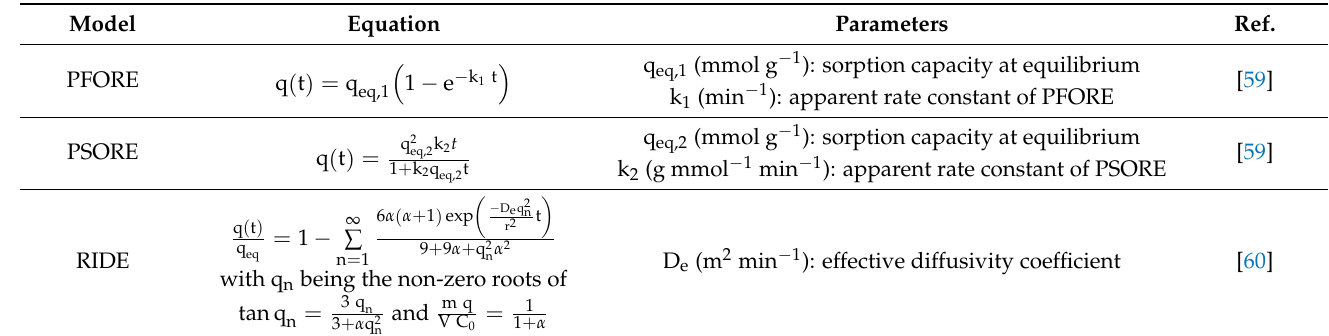
Table A2. Equations used for modeling uptake kinetics [58,59].